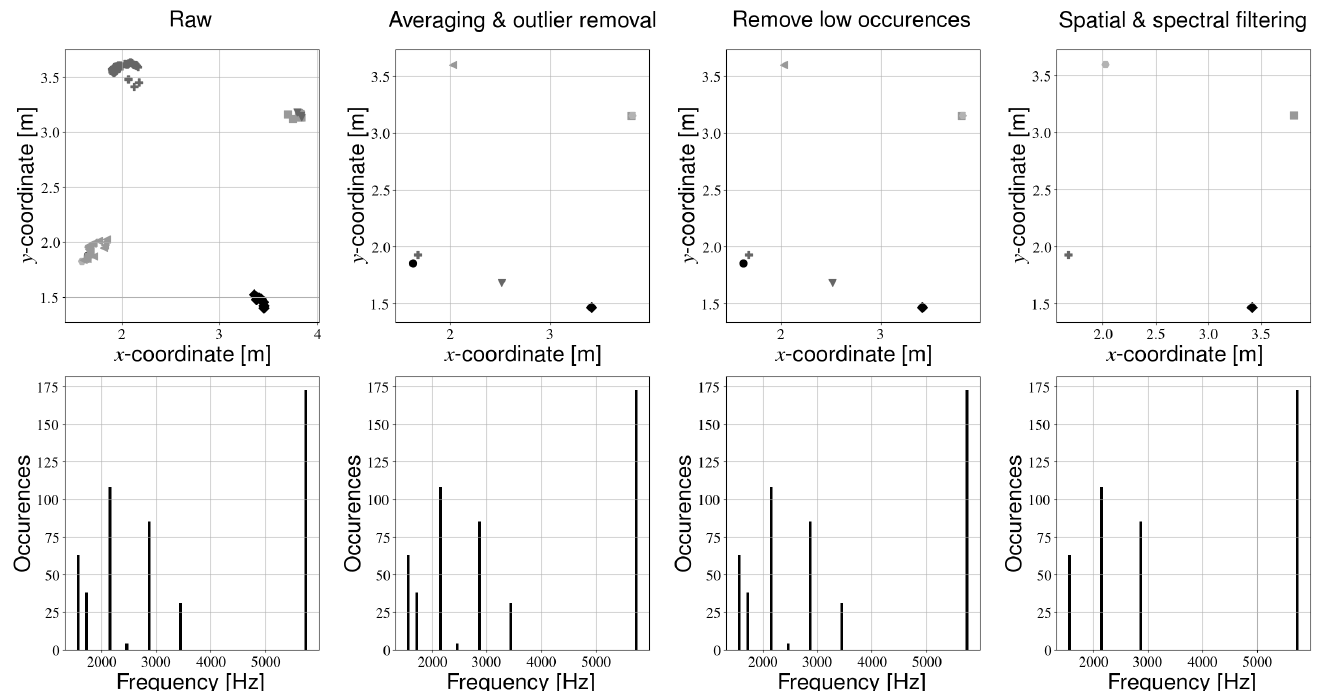
Figure 5. Filtering pipeline. The top row always indicates a light map, and a unique marker is used to indicate different frequencies. The bottom row shows the frequency spectrum corresponding to a certain processing step. From left to right: (1) raw output of the light mapping step, (2) light map after averaging coordinates of unique frequencies and removing outliers (3) light map after removing spurious observations (4) final results of spatial and spectral